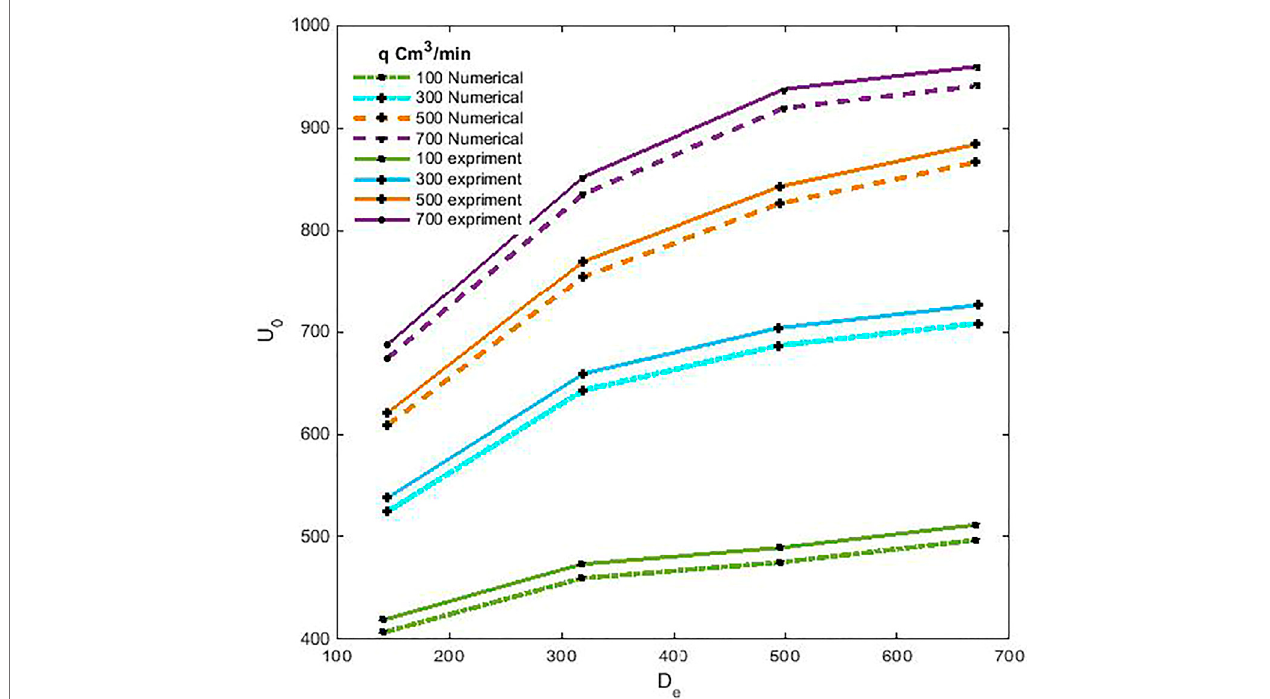
FIGURE 3 | The comparison between the numerical and experimental results for heat transfer coef fi cient.